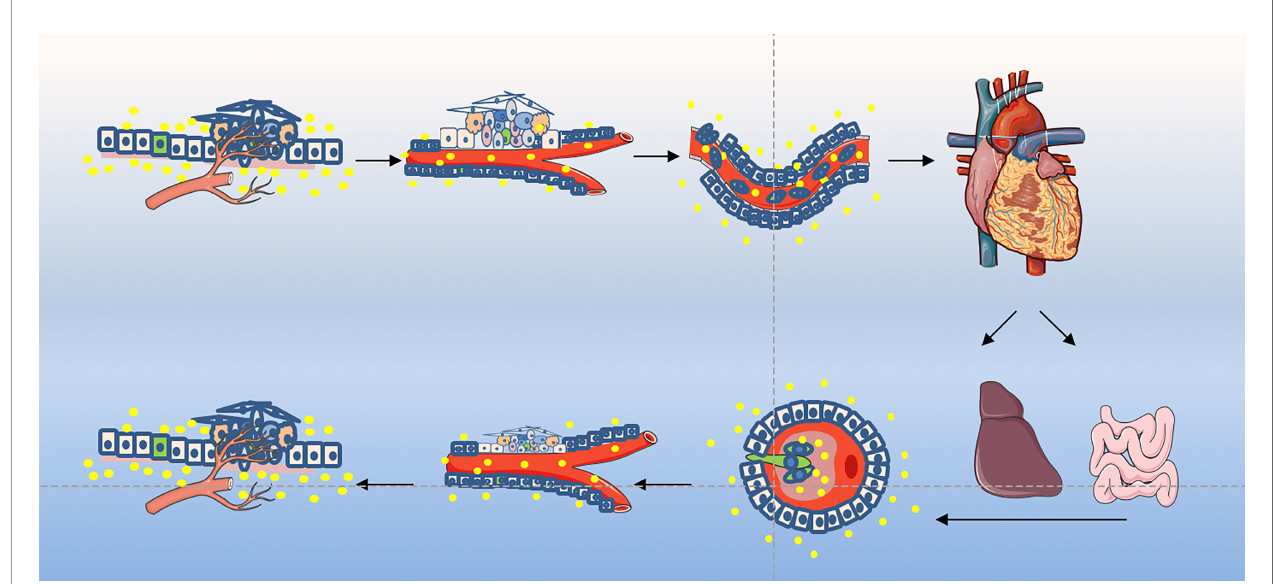
FIGURE 2 | Exosome play an important role in tumor invasion – metastasis cascade. This depiction of the invasion – metastasis cascade ascribes distinct steps to the overall process. The initial step in local invasion is for the in situ cancer cells to break through the basement membrane. They may then in fi ltrate into the lymphatic vessels or microvasculature. The latter may then transport these cancer cells through the systemic circulation to distant anatomic sites, where they may become trapped and subsequently exude, forming dormant micrometastases. Some micrometastases may eventually acquire the ability to colonize the tissue in which they land, allowing them to form macroscopic metastases. The fi nal step - colonization - appears to be the least ef fi cient of all. The little of successfully completing all steps of this cascade process explains why the likelihood of any individual cancer cell leaving the primary tumor and becoming the founder of a distant macroscopic metastasis is low. More suggestions proposed an alternative description involving two main stages: the fi rst enables the physical dissemination of cancer cells from the core of the primary tumor to the parenchyma of a distant tissue, while the second — colonization — depends on the adaptation of disseminated cancer cells to the microenvironment of this tissue. Exosomes as an essential part taking into the messages during the whole